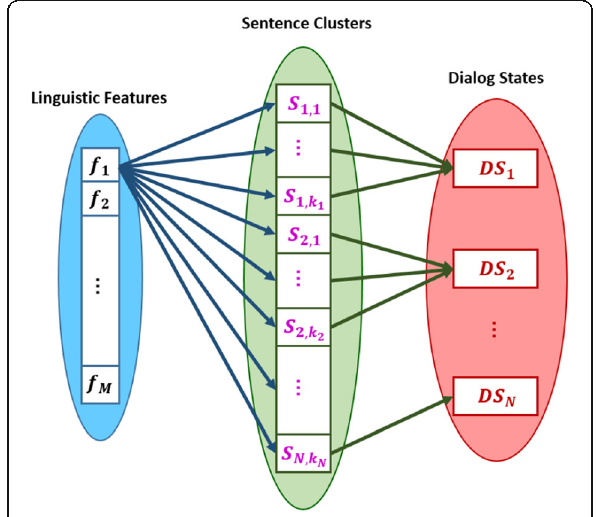
Fig. 9 Graphical representation of Eq.